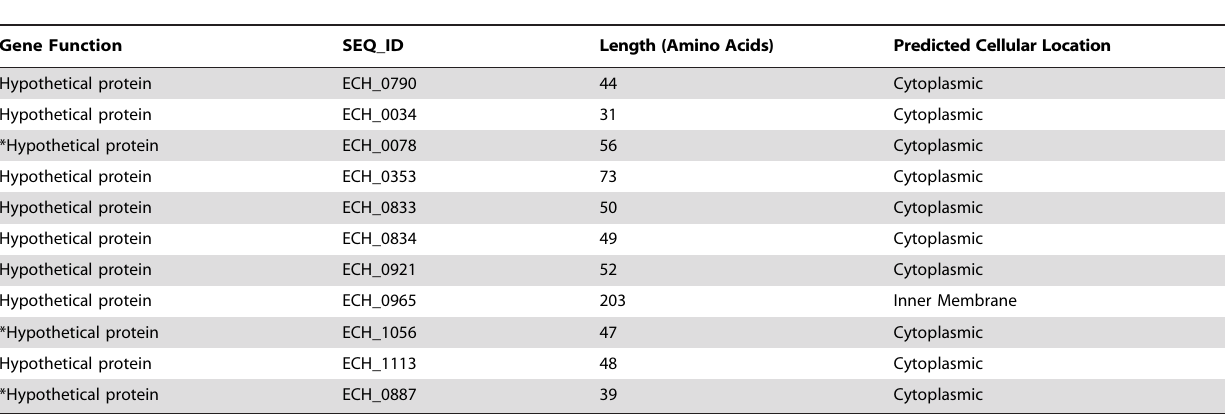
Table 2. Hypothetical genes expressed only in human (THP-1)